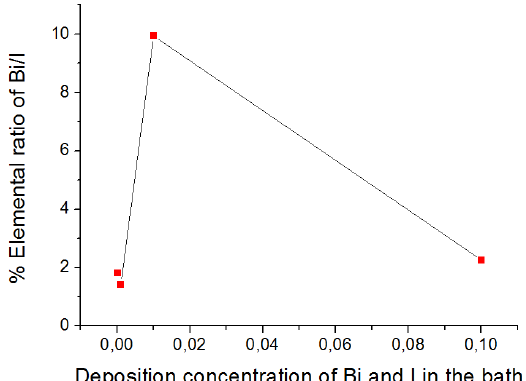
Fig. 8. EDX analysis of percentage of Bi/I